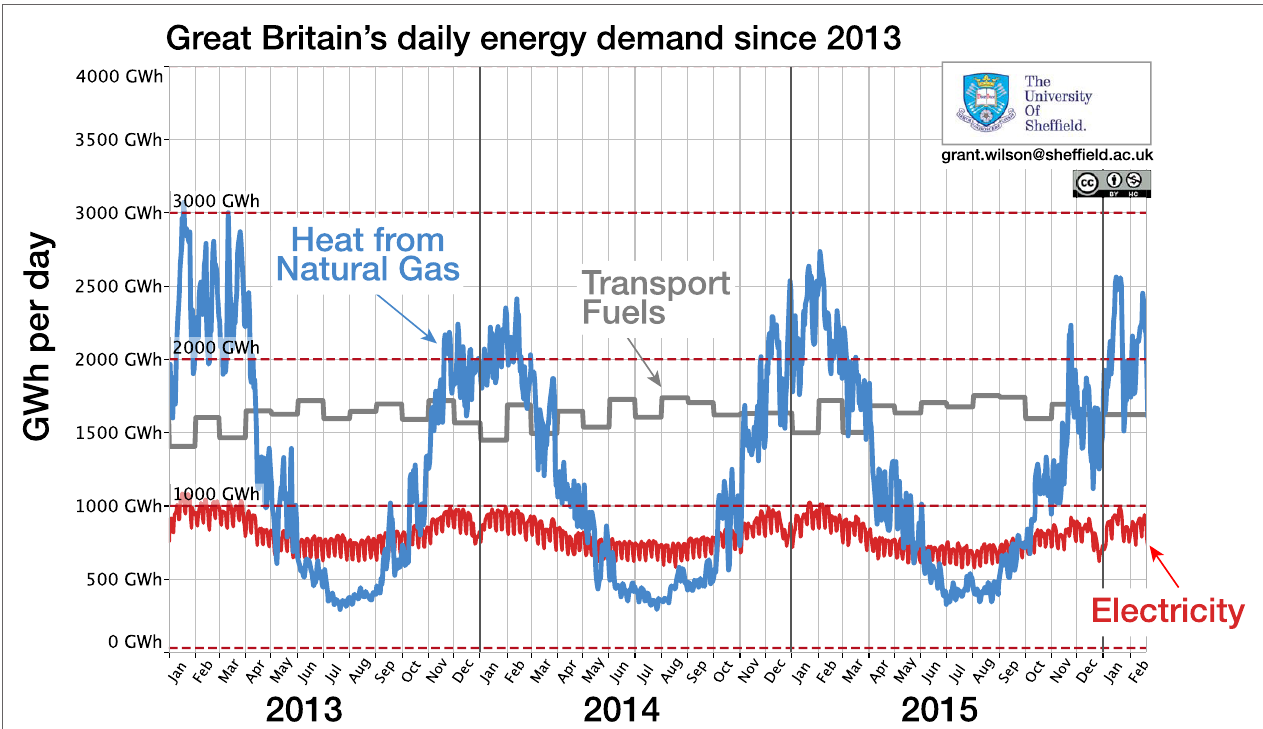
FiGUre 4 | typical saed with domestic heat from natural gas, electricity, and transport fuels on a daily basis